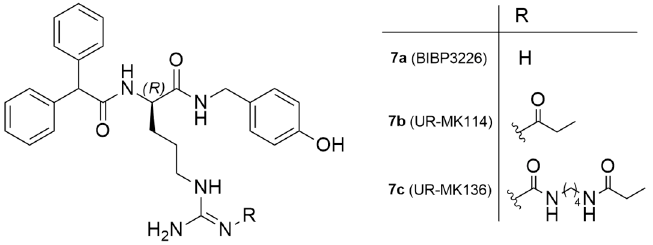
Figure 4. Chemical structure of Y 1 receptor antagonist BIBP3226 and Y 1 ligands derived from ar- gininamide-type antagonists.